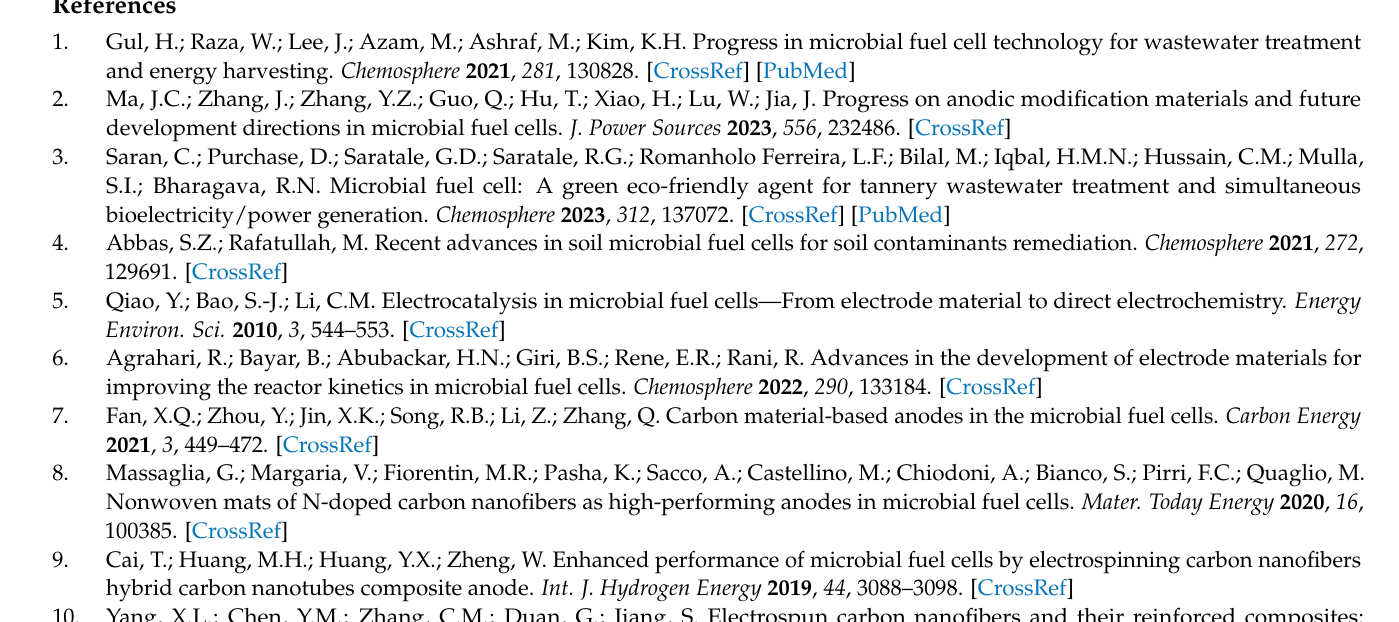
Figure S3. CV curves and peak current density at different scan rates of CNF electrode. Table